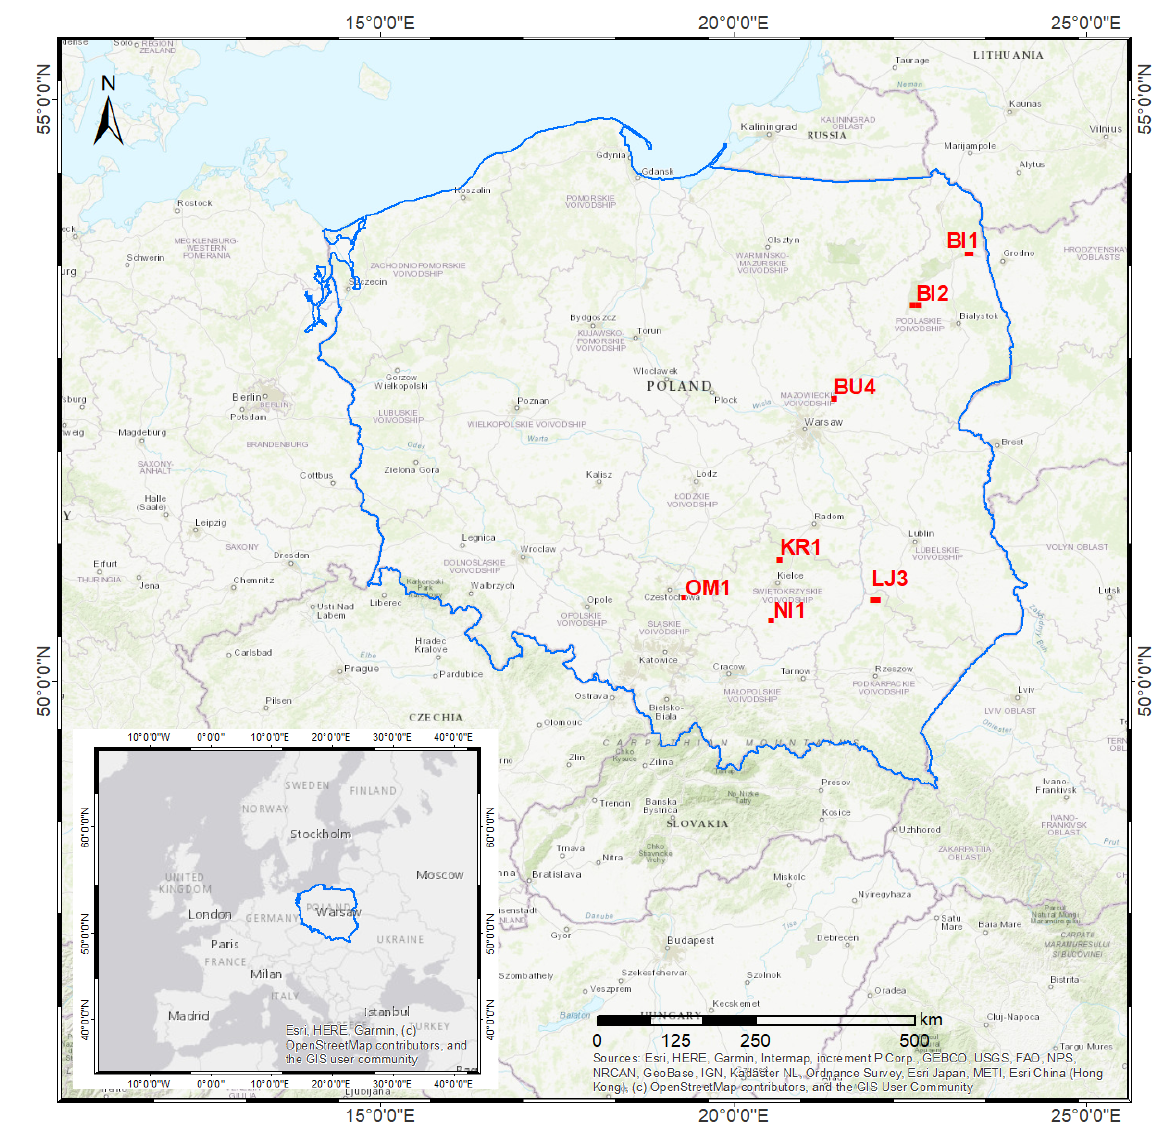
Figure 1. Location of the study areas of the succession process. Table 1. Description of the Natura 2000 sites studied.